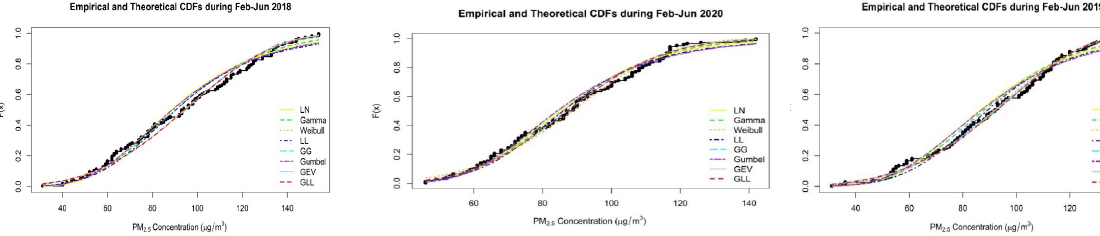
Fig. 5 . The CDF plot of the LN, gamma, Weibull, LL, Gumbel, GG, GEV, and GLL distributions superimposed on the empirical distribution function of PM 2.5 concentrations in the periods without and during the period with COVID-19 Fig. 5 presents graphs of the CDFs of the compared models superimposed on the empirical distribution function, which is defined as the proportion of sample observations less than or equal to the values of data. From the CDF's standpoint, the graphs suggest that although each compared model performs relatively persistent in fitting PM 2.5 concentrations in